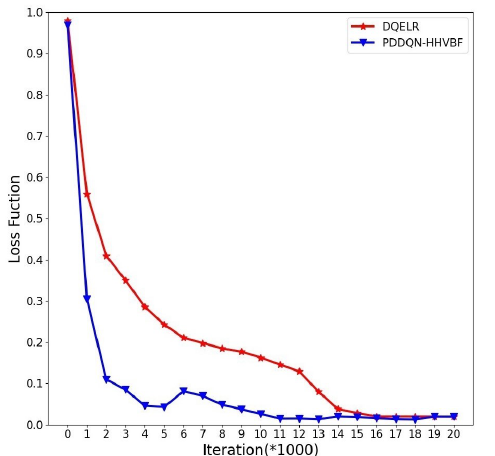
Figure 11. Comparison of the loss function of DQELR and PDDQN-HHVBF protocol with the number of